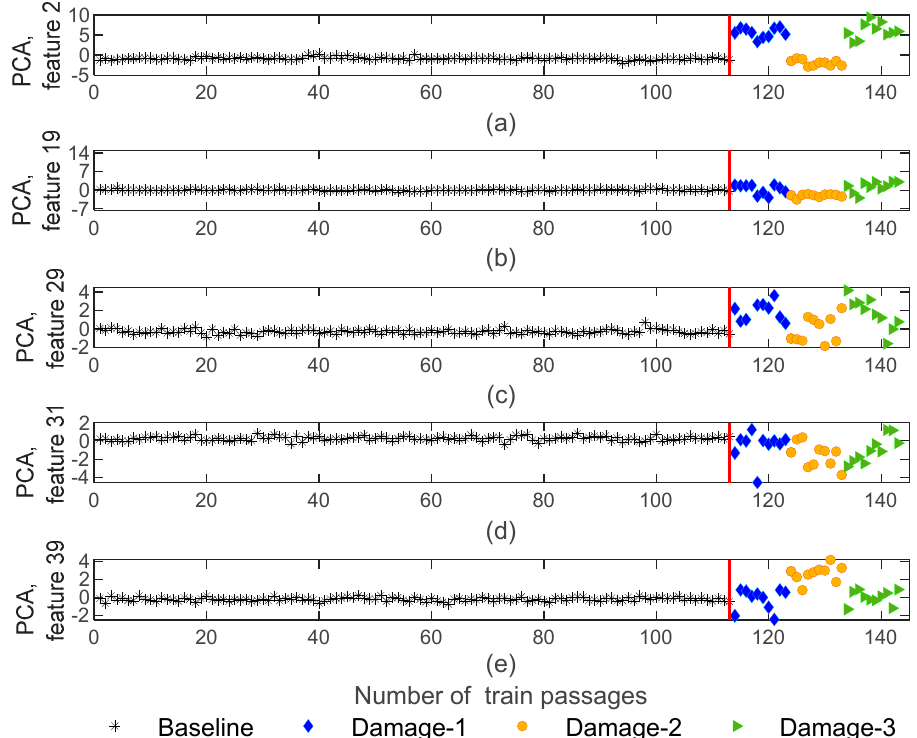
Figure 13. ARX—feature normalization for all 143 baseline and damage scenarios for accelerometer 3: ( a ) PCA for feature 2, ( b ) PCA for feature 19, ( c ) PCA for feature 29, ( d ) PCA for feature 31, ( e ) PCA for feature 39.